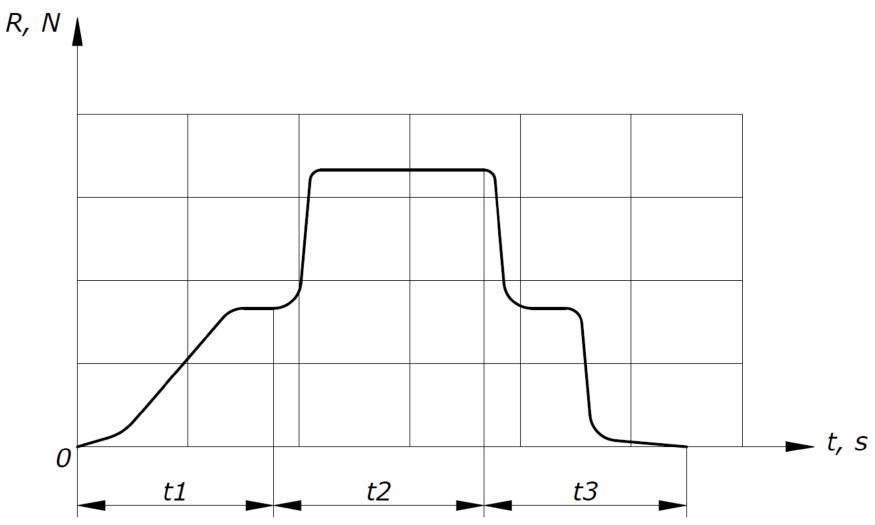
Figure 2. Test sequence